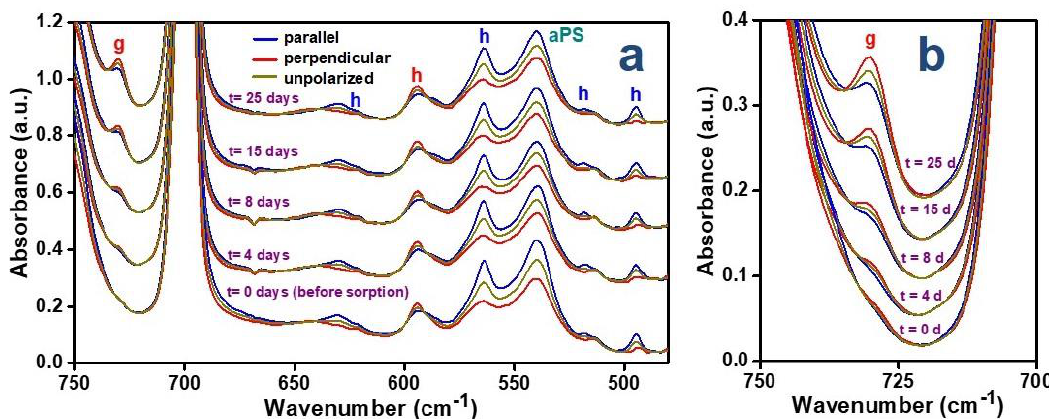
Figure 1. Polarized FTIR spectra of an axially oriented nanoporous-crystalline (NC) α form poly(2,6-dimethyl-1,4-phenylene)oxide (PPO) / atactic polystyrene (aPS) blend film collected with the polarization plane parallel (blue lines) or perpendicular (red lines) to the film stretching direction after different times of toluene sorption from a 50 ppm solution for two different spectral ranges: ( a ) 750–480 cm − 1 ; ( b ) 750–700 cm − 1 . Labels ( h ) and ( g ) indicate peaks of the host PPO crystalline phase and of the toluene guest, respectively.